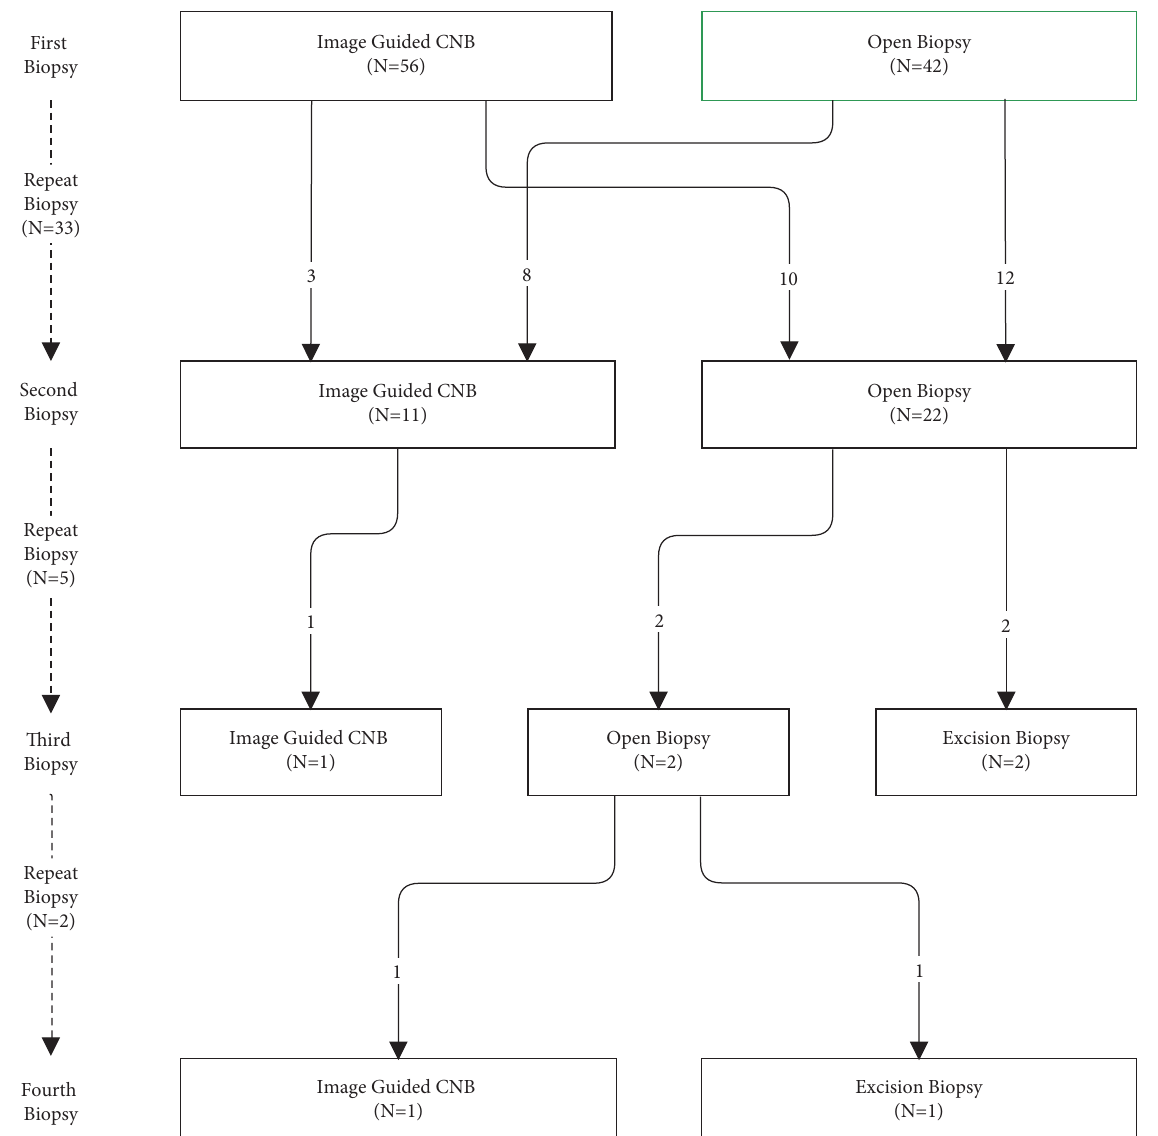
Figure 3: Biopsy type flowchart showing the biopsy technique used at each consecutive biopsy. The arrows indicate the number of patients moving from one biopsy type in the former row to another biopsy type in the latter